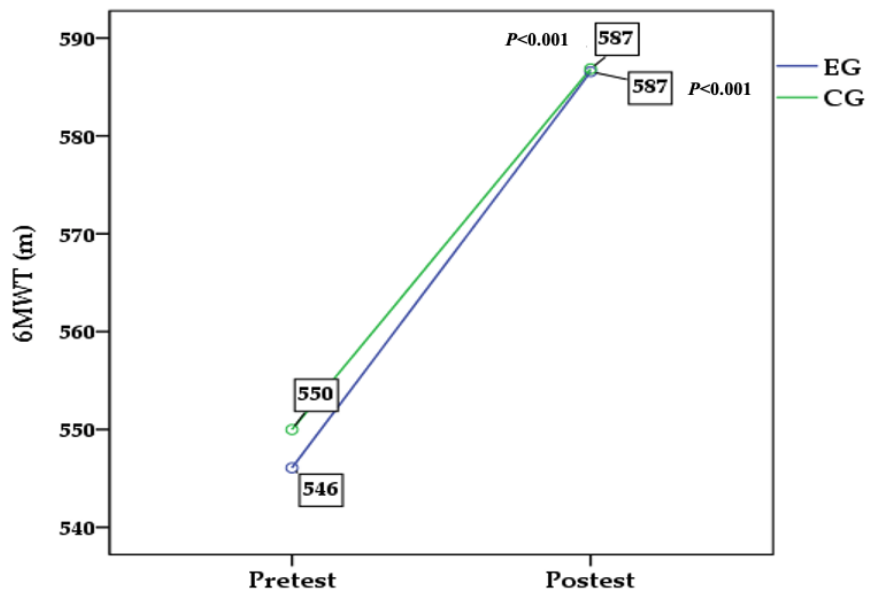
Figure 1. Performance in 6MWT before (pre-test) and after the intervention (post-test). The participants’ weight status before (pre-test) and after (post-test) training pro- gram according to the Chilean state are shown in Figure 2. EG, reduced significantly the percentages of overweight and obesity after the intervention.